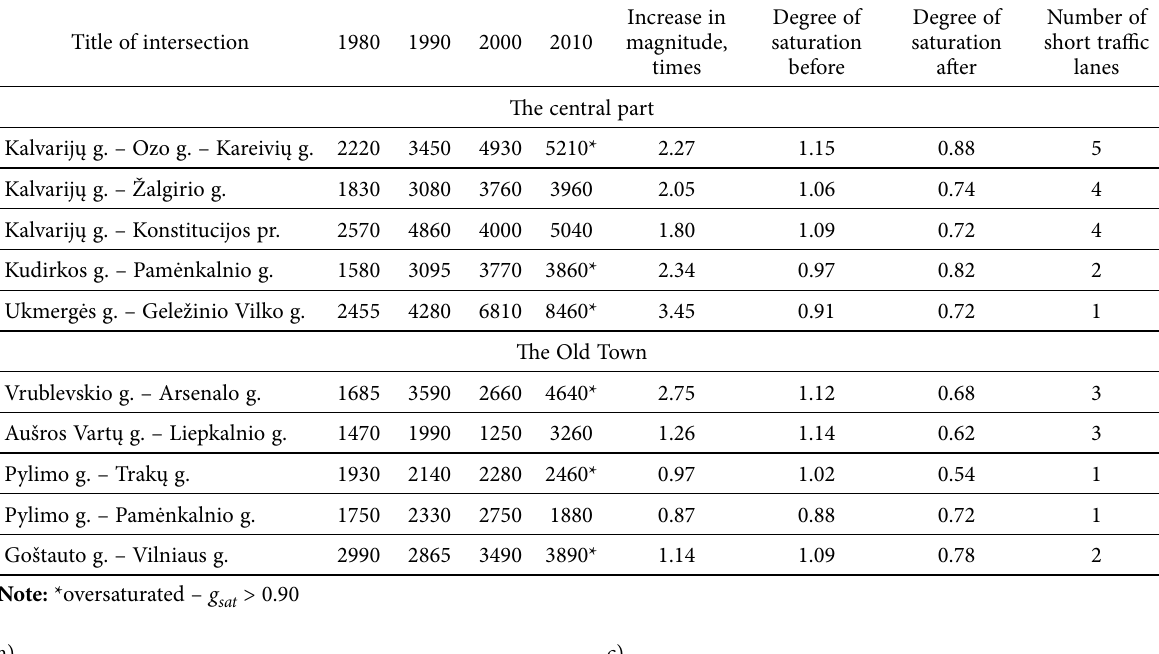
Table 1. Transport flow dynamics at typical intersections of the Old Town and the central part of Vilnius (veh/h during rush hours)